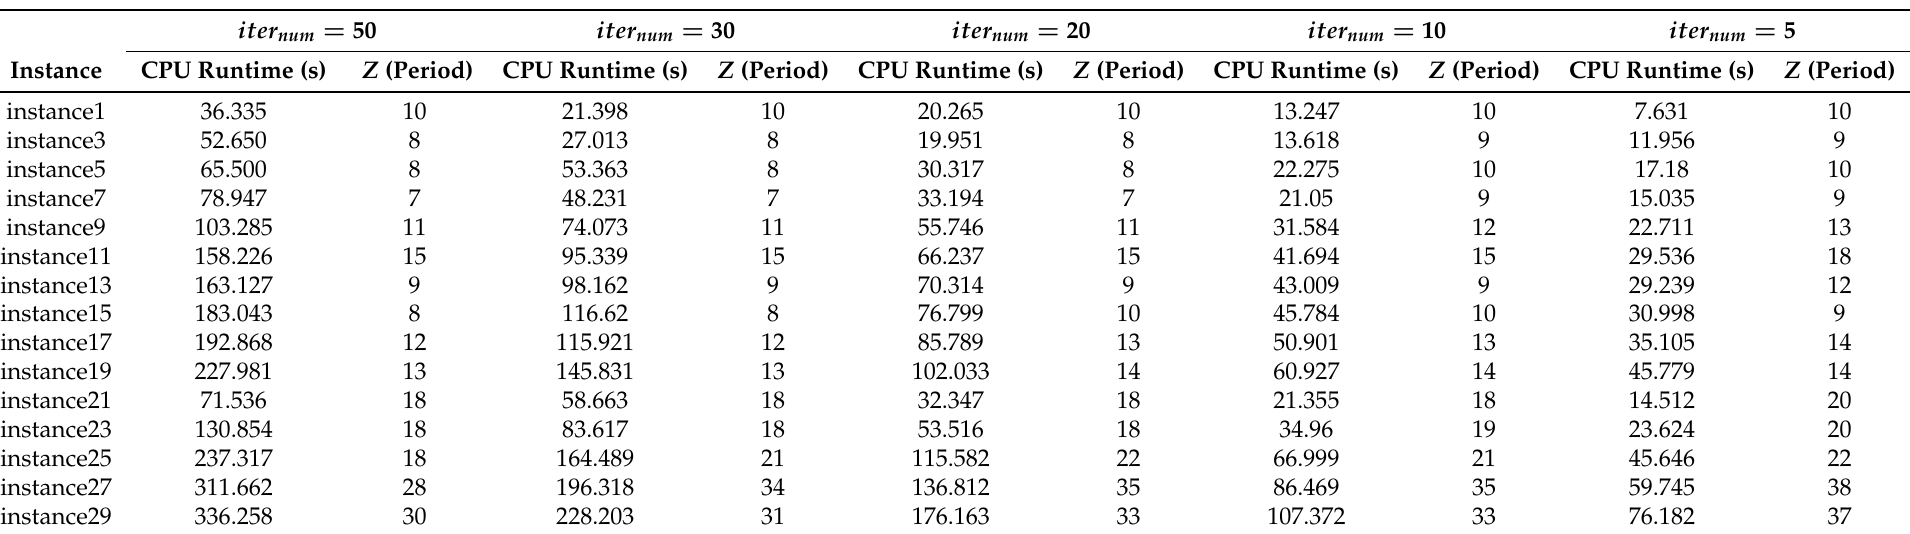
Table 6. CPU runtime and objective value under different iteration